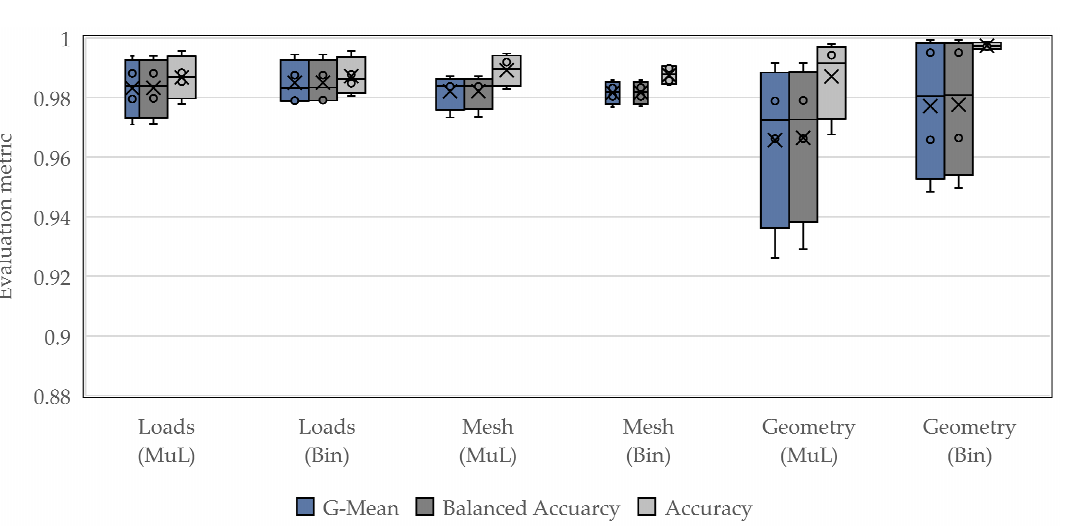
Figure 12. Results for the test dataset with different evaluation metrics for the two classification approaches.